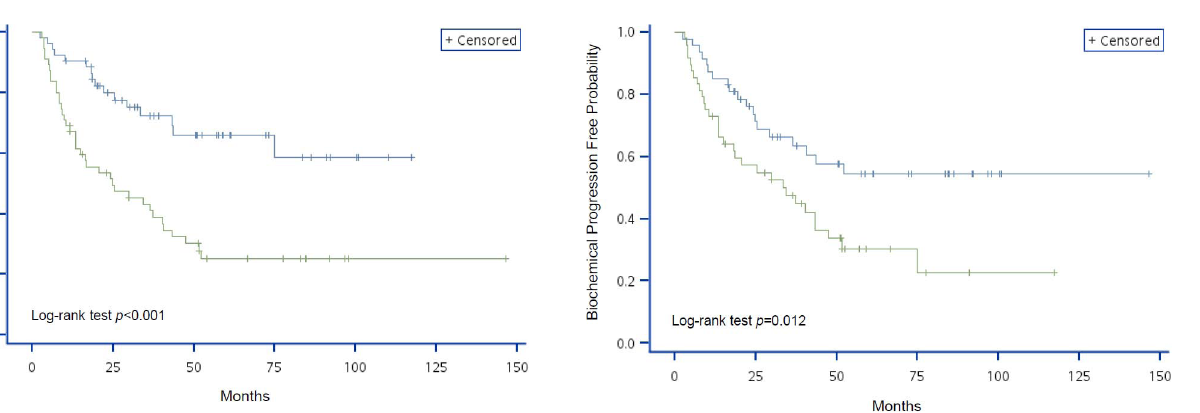
Figure 3. Kaplan-Meier analysis of BCP-free probability for advanced prostate cancer patients by risk group using hemoglobin levels. The blue line represents hemoglobin levels $ 12.7 g/dL and the green line represents hemoglobin levels , 12.7 g/dL. P- value of Log-rank test=0.012.